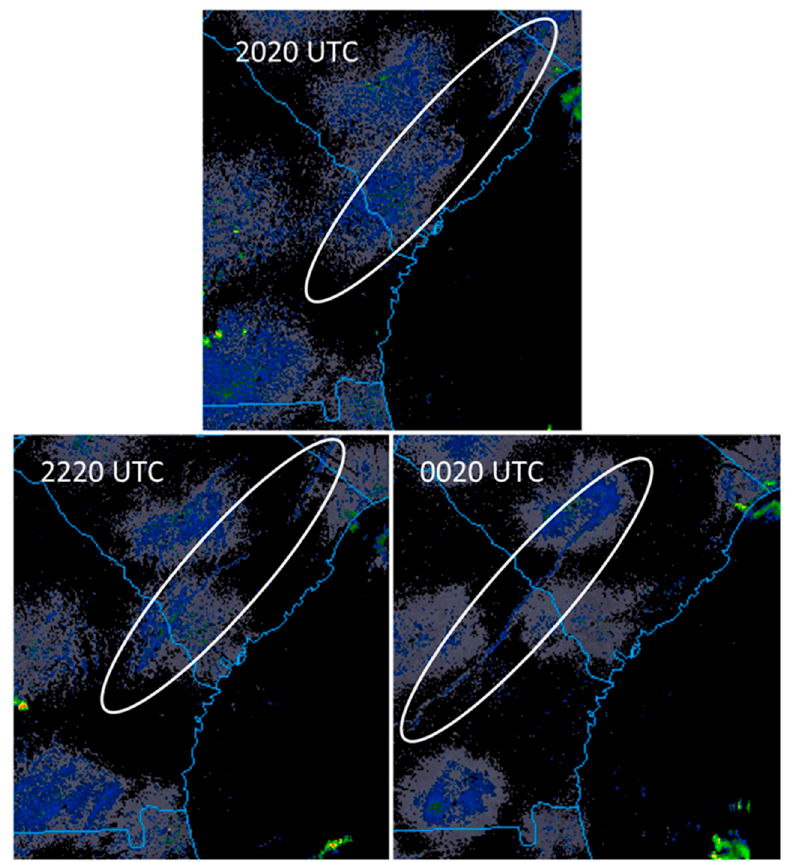
Figure 1. A depiction of the sea breeze signal as observed on radar from 13–14 May